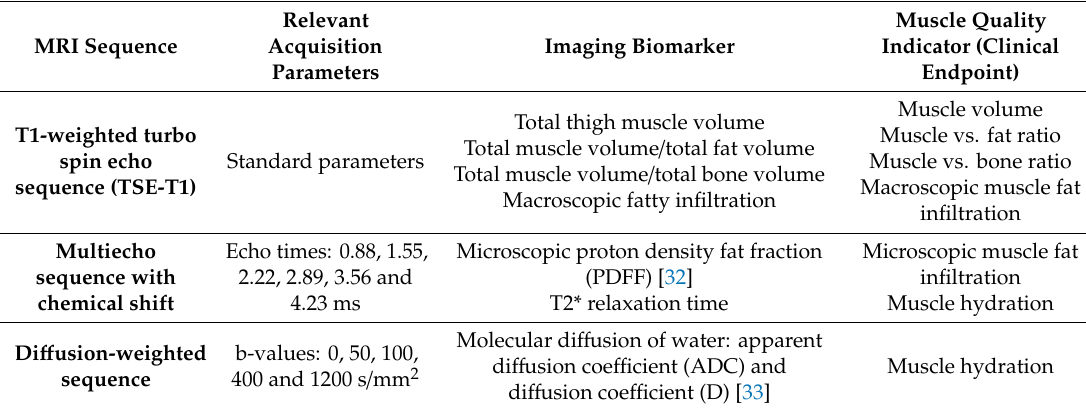
Table 1. Imaging biomarkers obtained from MRI